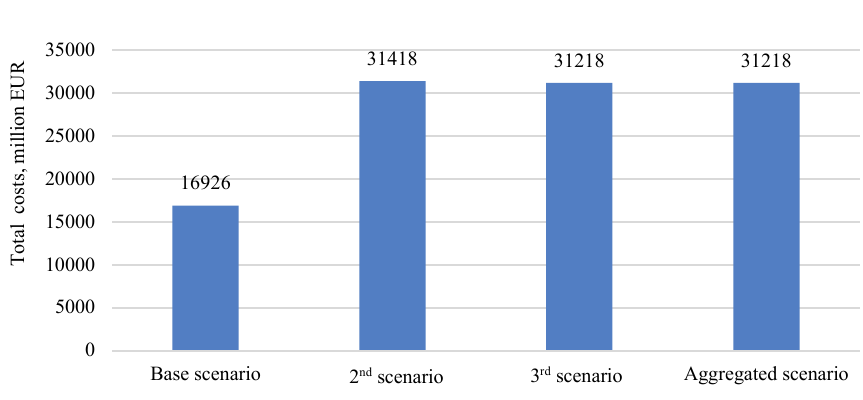
Fig. 9. Investment costs of FBVM scenarios, thousand EUR.